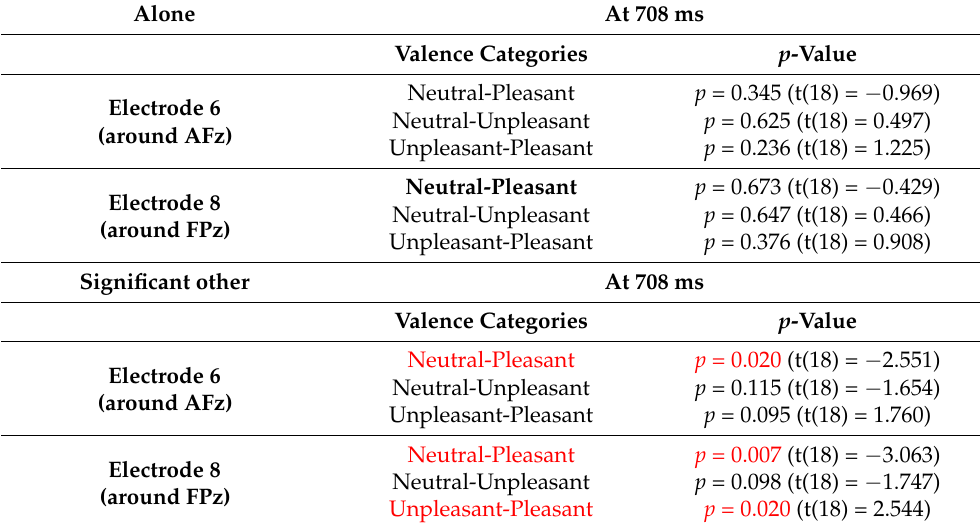
Table 1. p -values of ERPs at electrode 6 and 8 708 ms post stimulus onset between the respective valence categories in the alone and the significant other condition. Significant values are marked in red. Trends are marked in